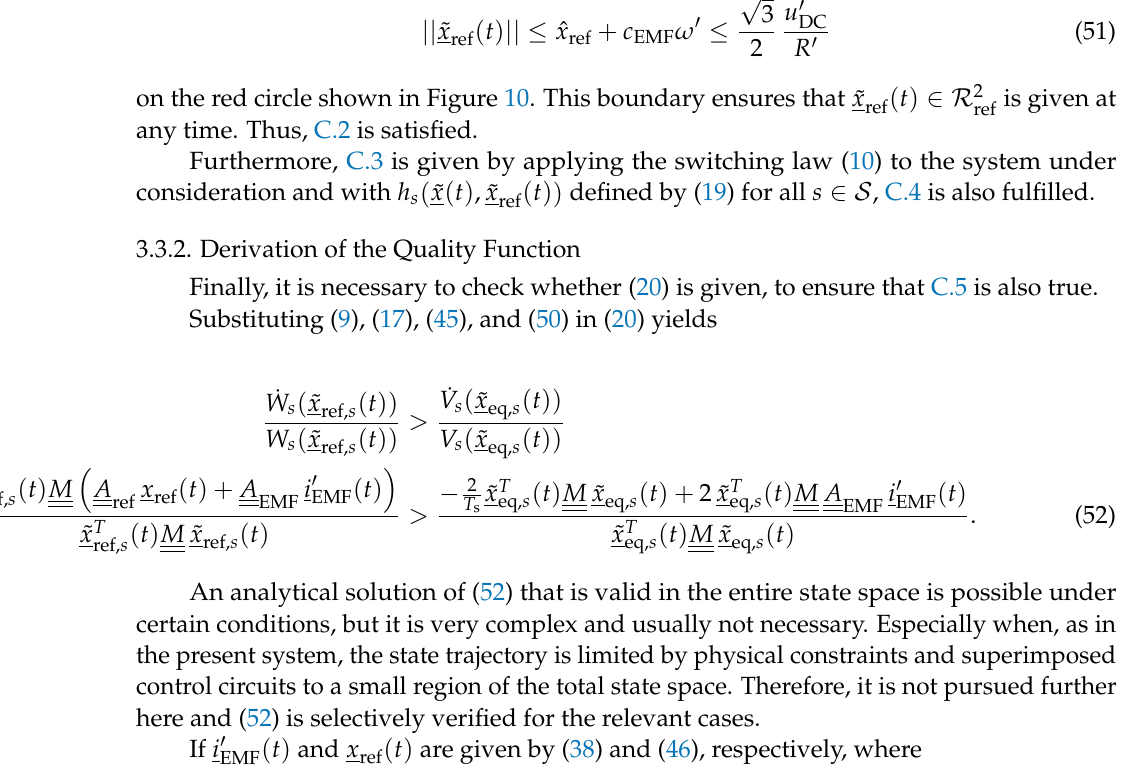
Figure 10. Location of x eq, s ∀ s ∈ S with i (cid:48) possible x ref ( t )